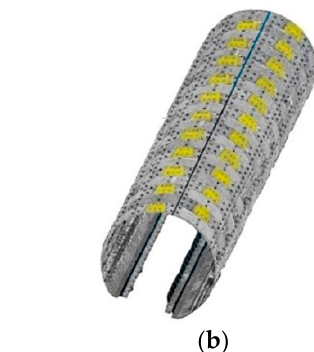
9 of 20 Figure 6. Recognition results of longitudinal ring seams.